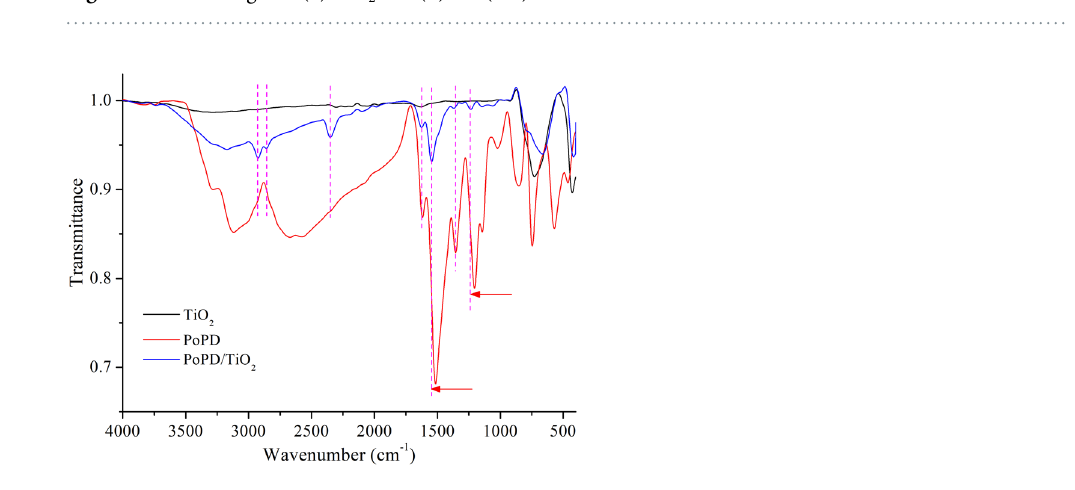
Figure 4. FT-IR spectra of TiO 2 , PoPD, and